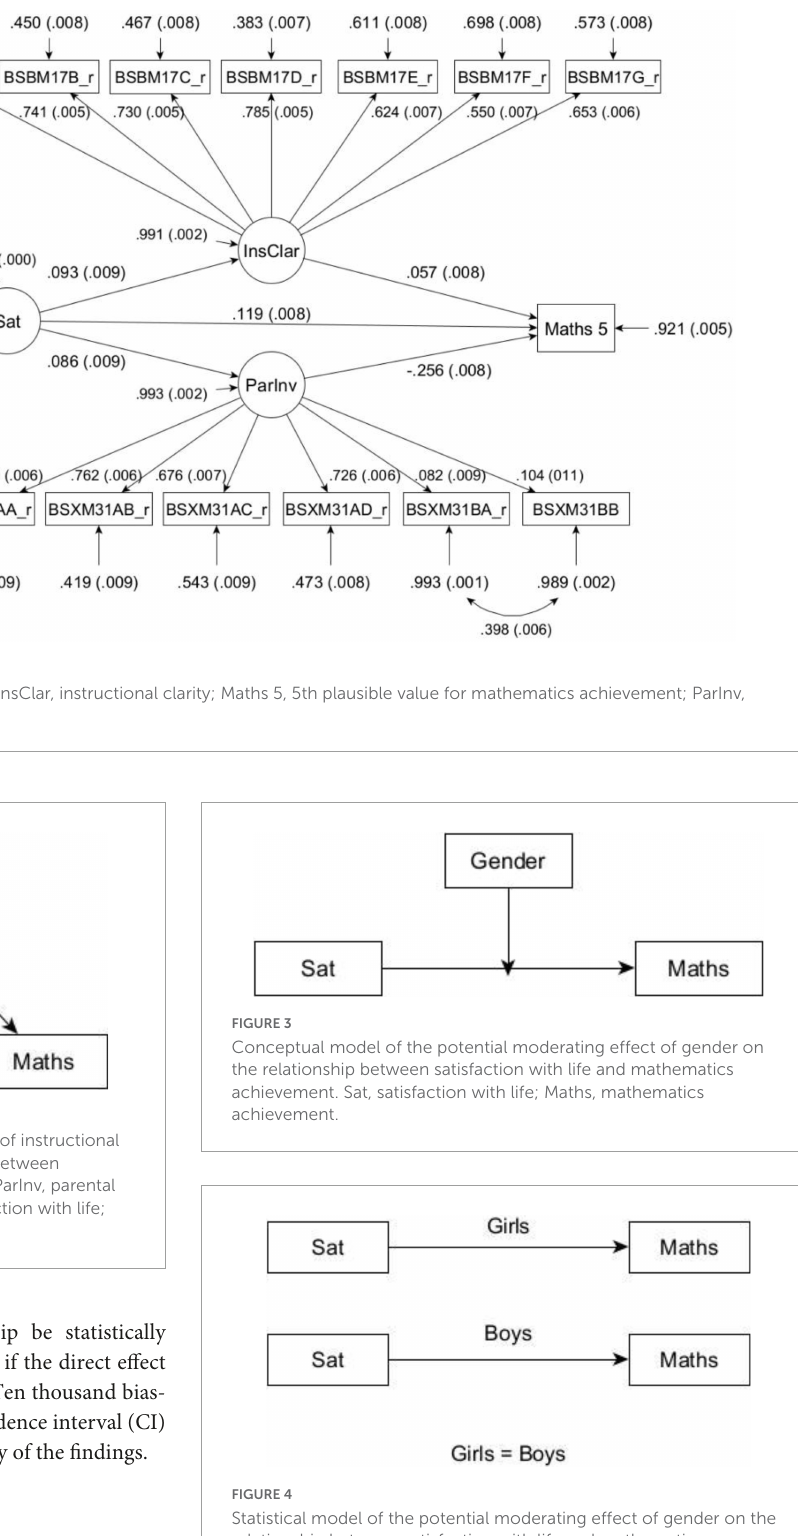
FIGURE4 Statistical model of the potential moderating effect of gender on the relationship between satisfaction with life and mathematics achievement. Sat, satisfaction with life; Maths, mathematics